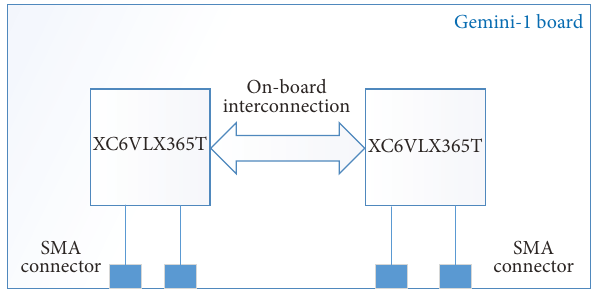
Figure 7: Top-level view of